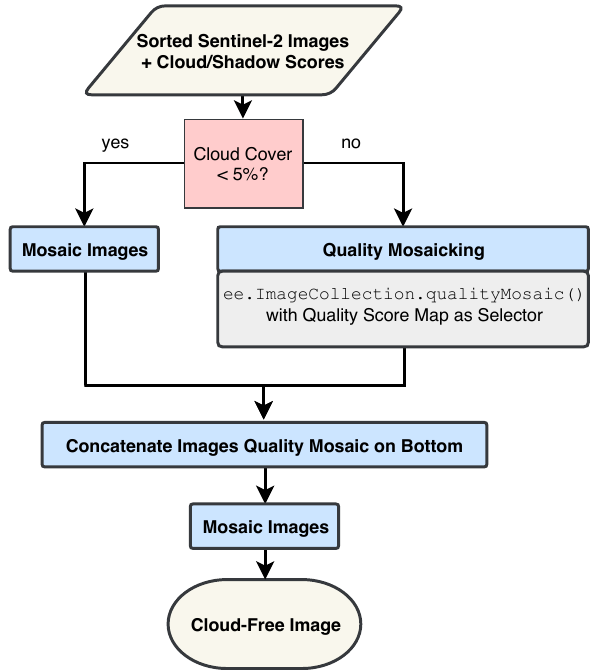
Figure 6. Flowchart of the Image Merging module, which finally creates the cloud-free Sentinel-2 image from the pre-processed image collection.